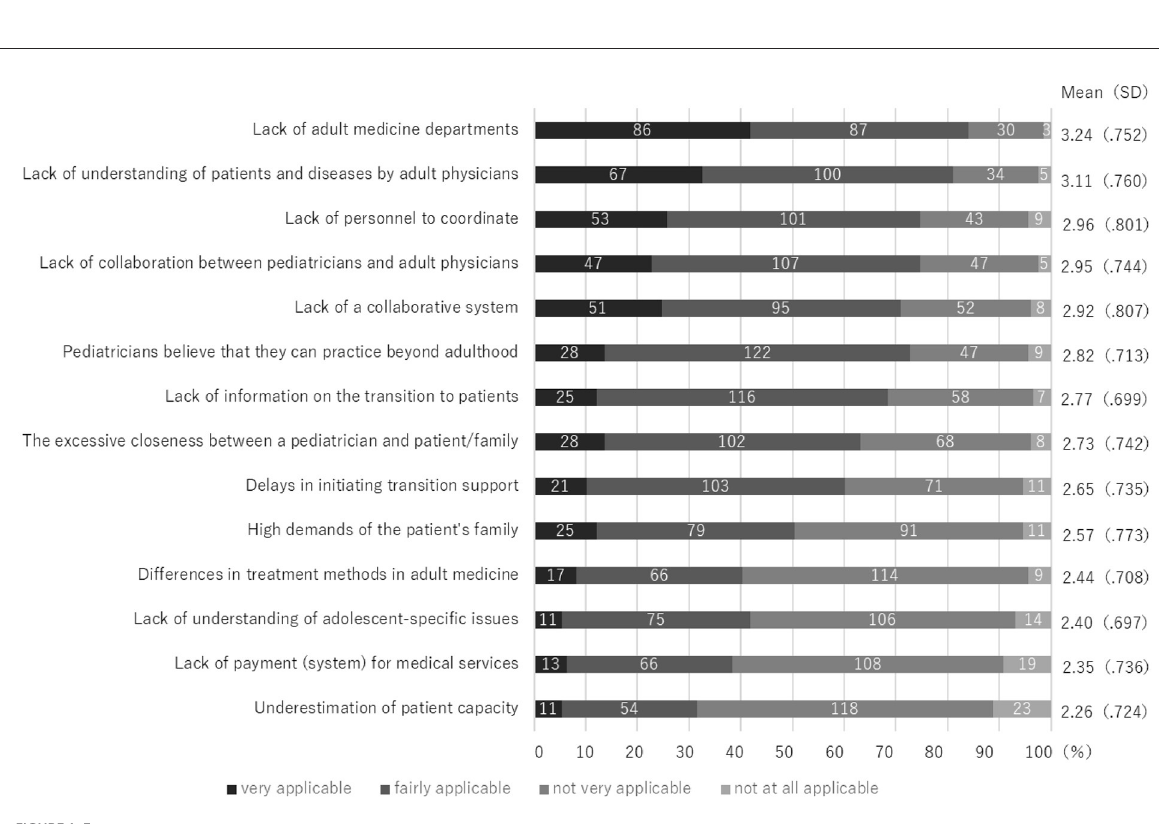
FIGURE1-3 Barriers to Transition from Pediatric to Adult care: Medical/Infrastructure factors ( n =